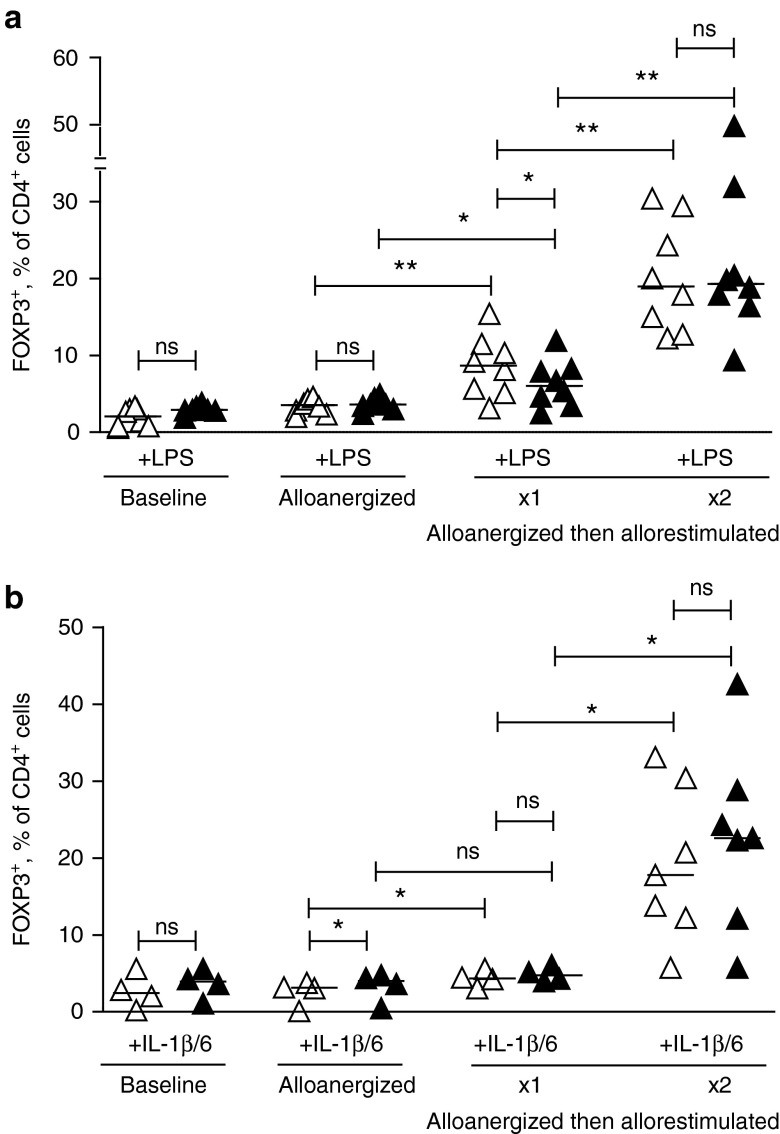
Expansion of CD4+ regulatory T-cells (Treg) after alloanergization is maintained in proinflammatory conditions. (a) FOXP3+ Treg, expressed as percentage of total CD4+ cells, after alloanergization and repeated exposure to alloantigen in the absence or presence of lipopolysaccharide (LPS). Graph depicts results from eight different HLA-mismatched stimulator-responder pairs. P values are for two-tailed student's t-test. Horizontal lines are medians. *P < 0.05, **P < 0.01, ns, not significant. (b) FOXP3+ Treg, expressed as percentage of total CD4+ cells, after alloanergization and repeated exposure to alloantigen in the absence or presence of IL-1β and Il-6. Graph depicts results from seven different HLA-mismatched stimulator-responder pairs. P values are for two-tailed student's t-test. Horizontal lines are medians. *P < 0.05, **P < 0.01, ns, not significant.